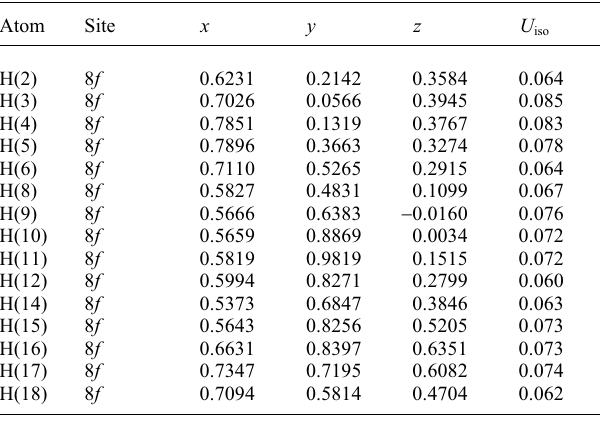
Table 2. Atomic coordinates and displacement parameters (in Å 2 )